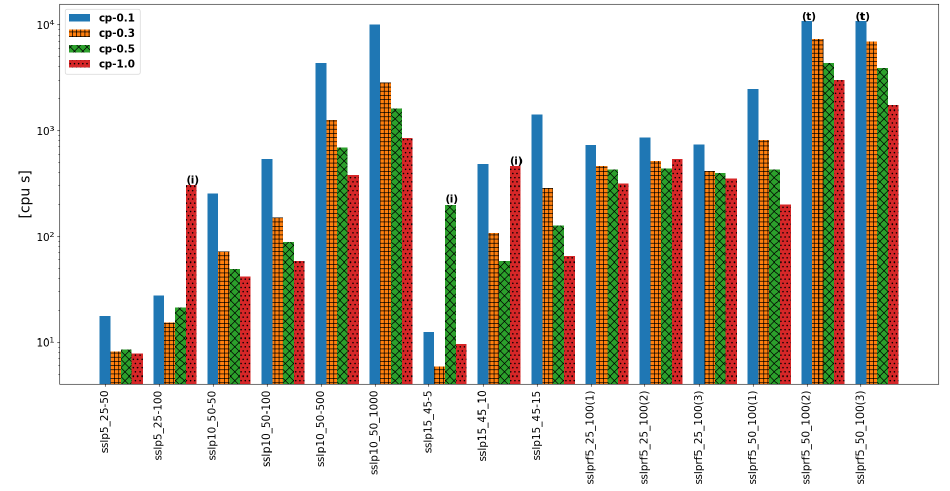
Figure 2. Walltime for PH to solve SSLP instances using different cost proportional